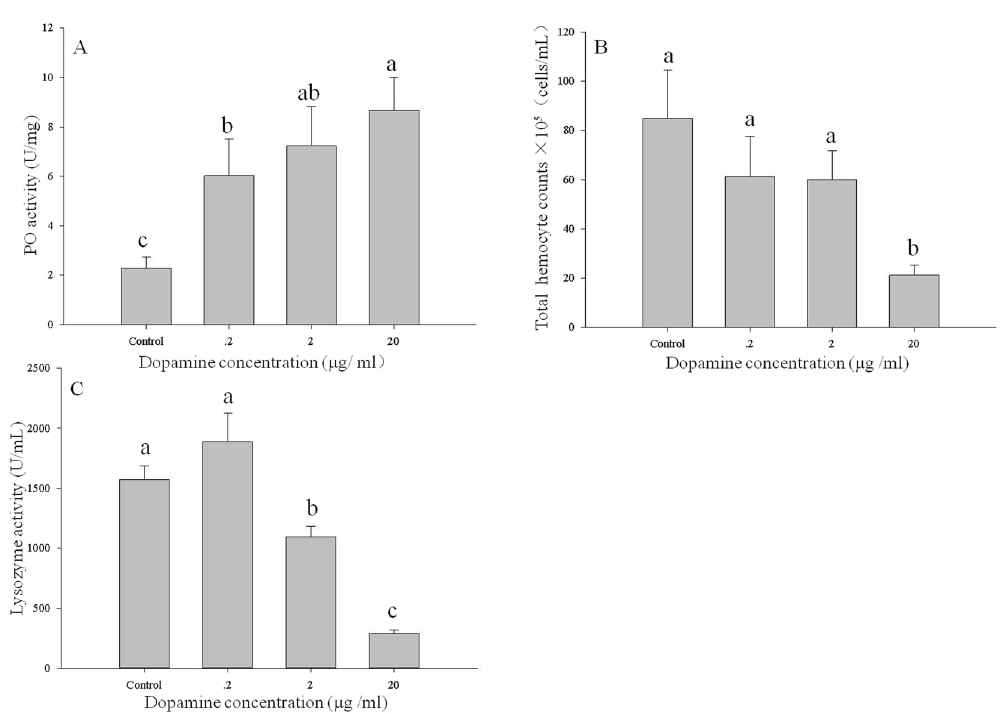
Figure 6. The three measures of immune function of M . separata larvae injected with different concentrations (0.2, 2, 20 µ g/mL) of dopamine solution. ( A ) Phenoloxidase activity. ( B ) Total haemocyte count. ( C ) Lysozyme activity. Values are means ± SE. Different letters indicate significant differences at P <